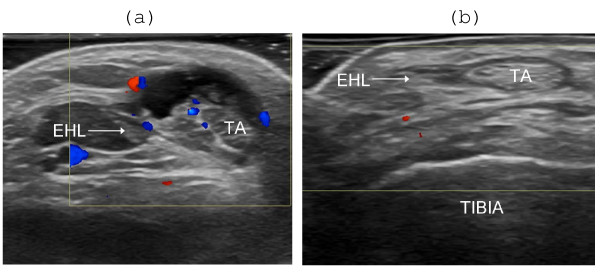
Effect of US-guided steroid injection in the sheath of the tibialis anterior tendon . (A) TA = tibialis anterior tendon, EHL = extensor hallucis longus tendon. Transversal scanning plane before steroid injection. Anechoic effusion, hyperechoic synovial hypertrophy and synovial hyperemia in the tendon sheath. (B) One week after injection there is complete regression of effusion, hypertrophy and hyperemia.